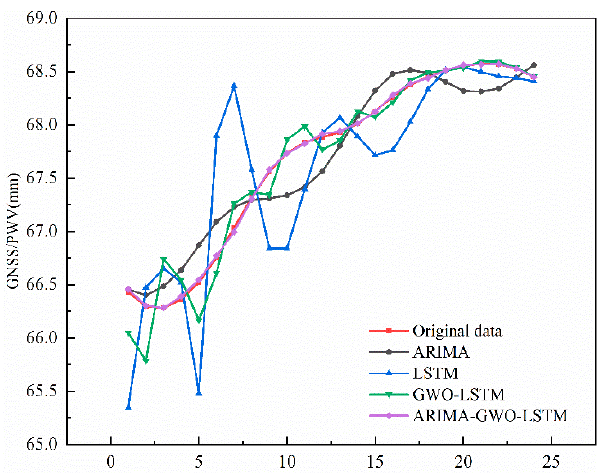
Figure 11. Comparison of the prediction results obtained with high-frequency component models.